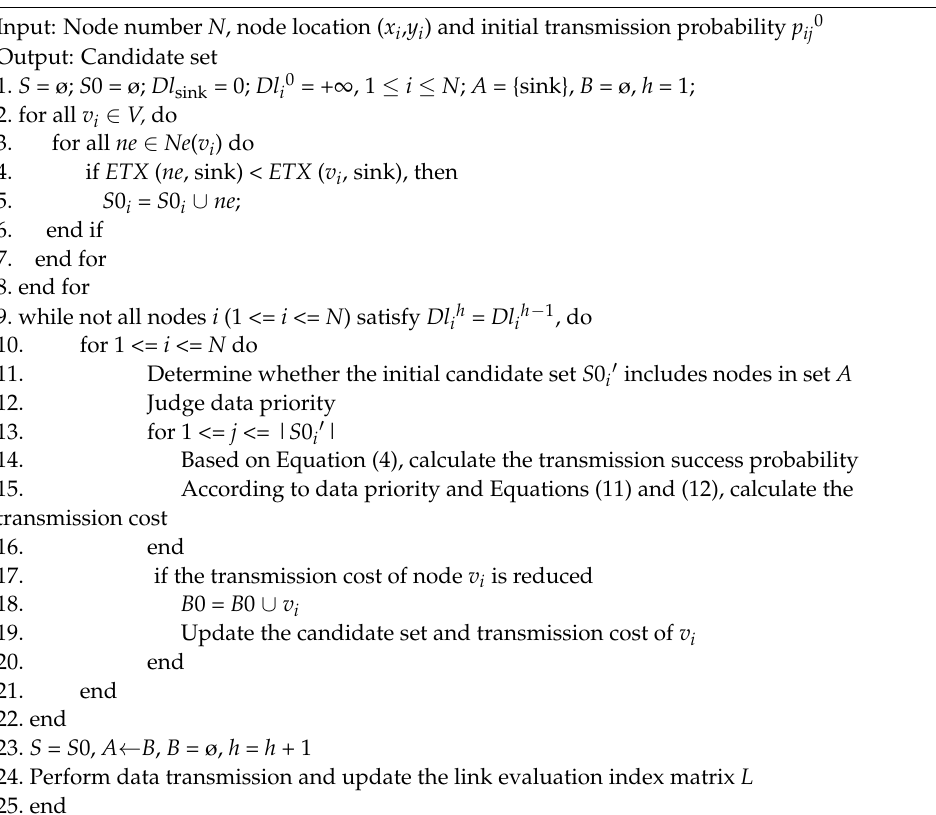
Algorithm 1. Candidate Set Construction